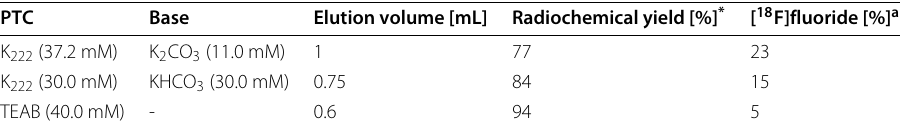
Table 1 Results of the optimisation study with tosylate DPA-714 precursor in anhydrous acetonitrile at 90 °C after 10 min with different PTC/base systems. Each run was performed with the indicated volume of the PTC/base combination dissolved in acetonitrile/water 70/30 v/v% for Entry 1 and 85/15 v/v% for Entries 2 and